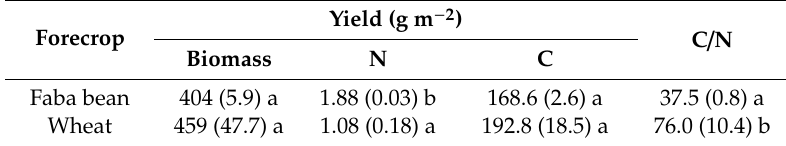
Table 1. Parameters of faba bean and wheat plant residues (forerops) with standard deviations ( n = 3).